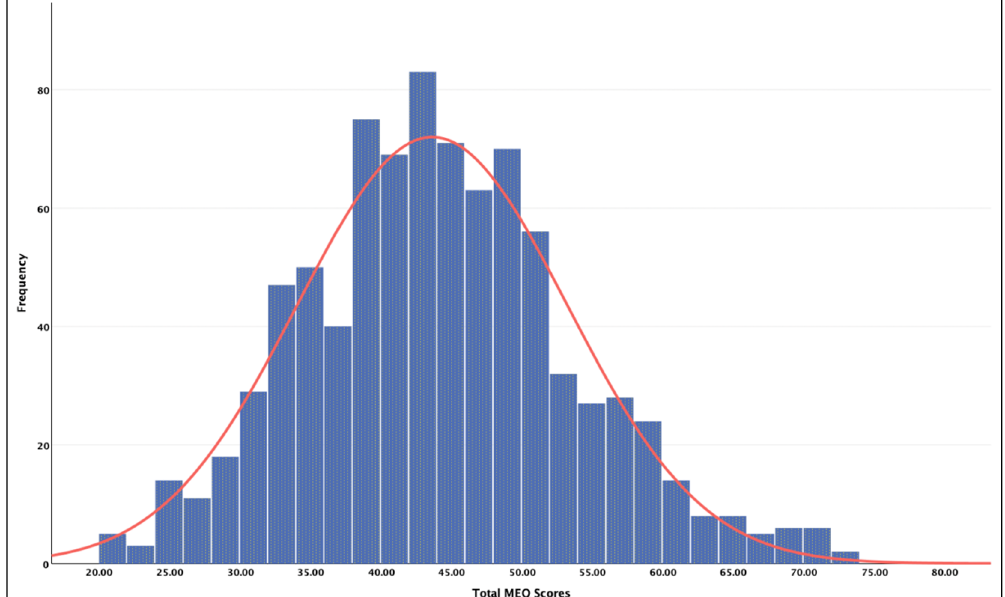
Figure 1. Distribution of total MEQ scores in the current sample, in which scores between 16 and 41 indicate an evening preference, scores between 42 and 58 indicate an intermediate preference, and scores between 59 and 86 indicate a morning preference.